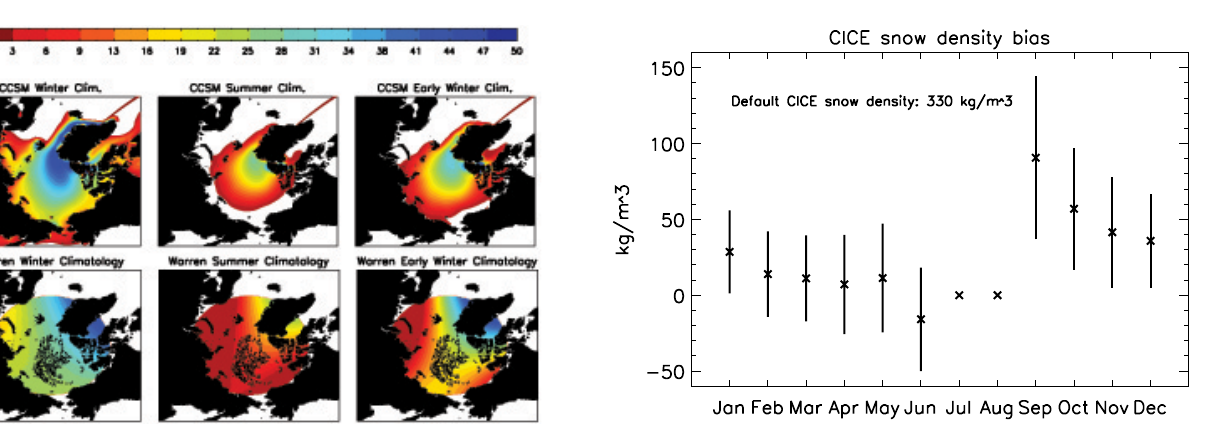
Fig. 3. Snow density bias: CICE model default less in situ mea- surements; bars indicate standard deviations (in the in situ measure-